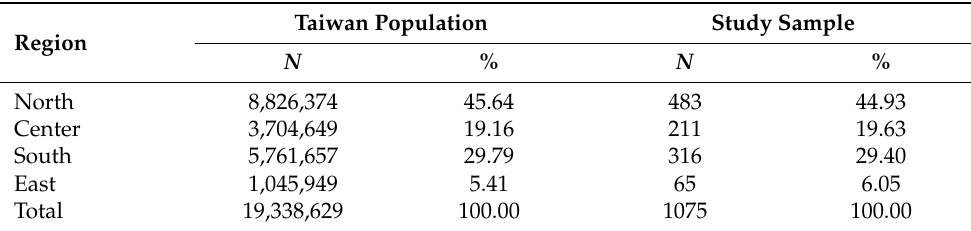
Table A1. Comparison of the distribution of residence between study participants and the general population of Taiwan.